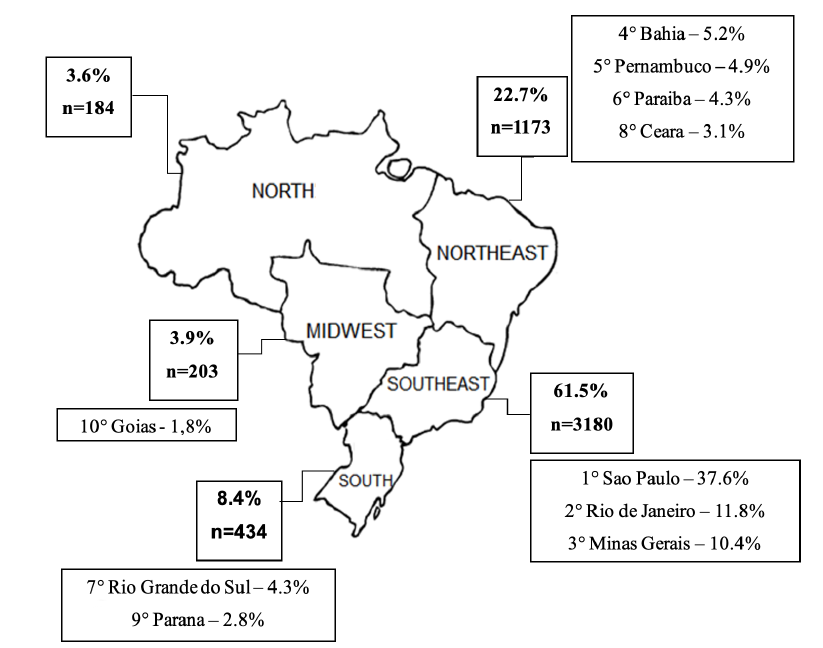
FIGURE 1 - Distribution of responses received by country region and main